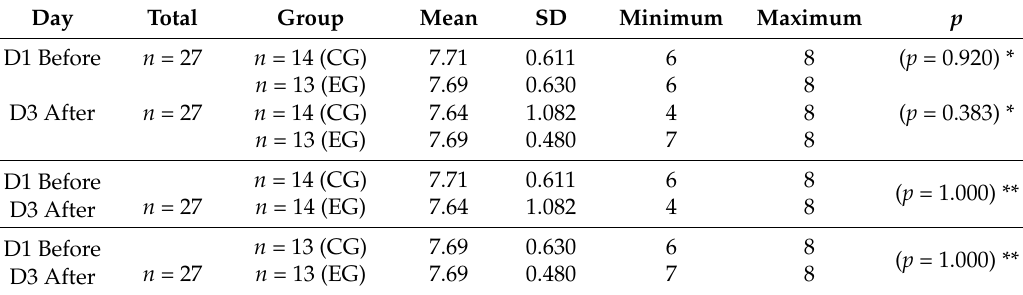
Table 3. Scores on the Beliefs subscale before and after the